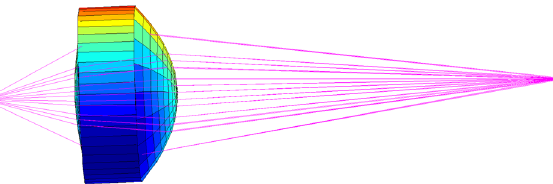
Figure 6. 3D optical layouts plotted by plotted by the self-made MATLAB program.